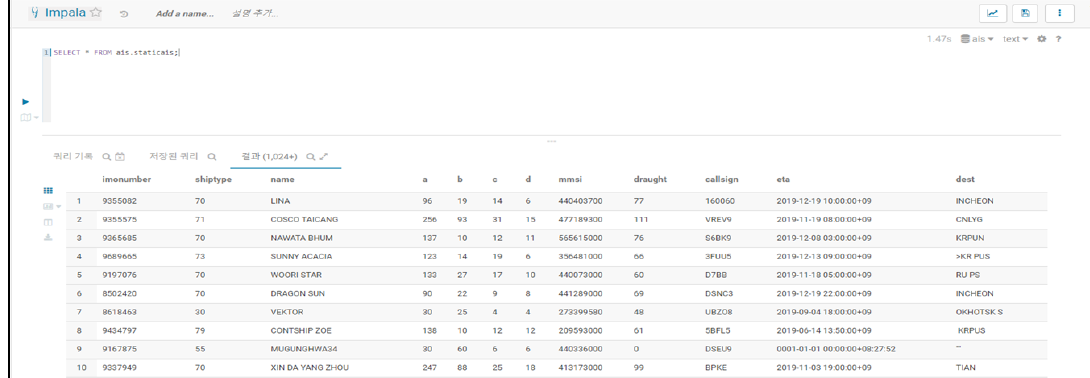
Figure 7. Contents of the AIS Static table.